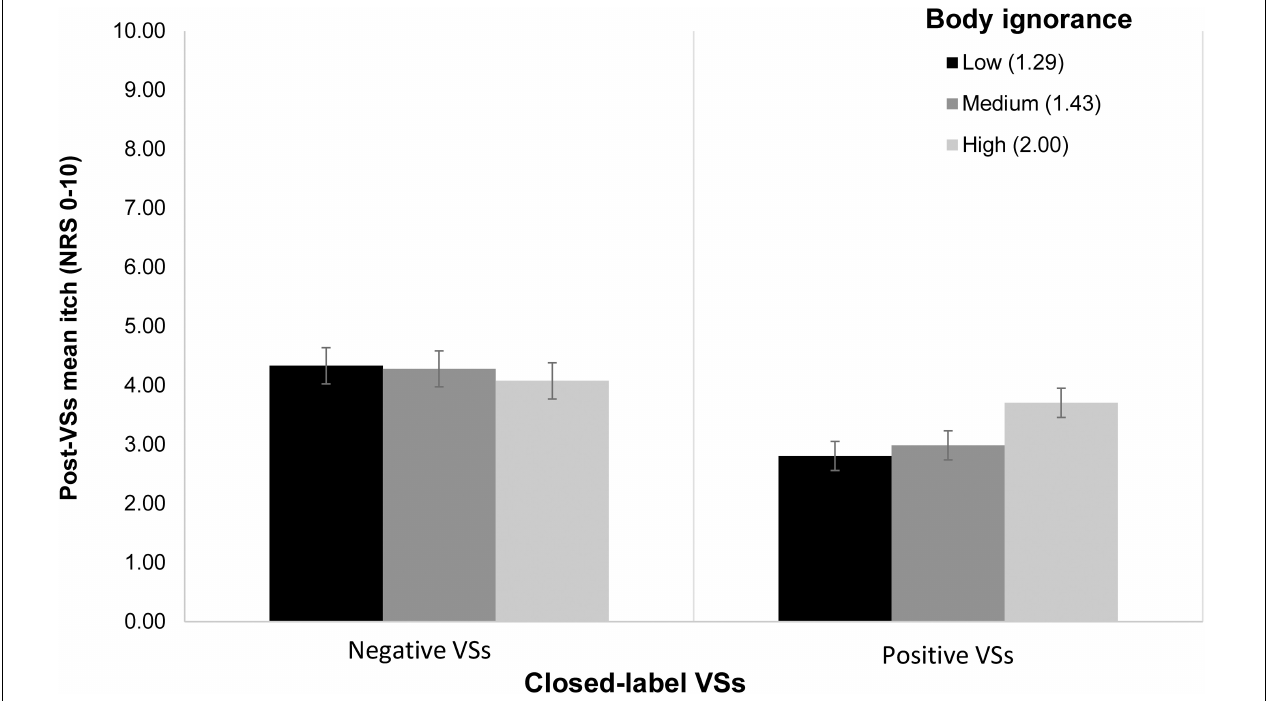
FIGURE 4 | Depiction of the marginal moderation of the direct effects of VSs on mean itch by ignorance of bodily signals in the closed-label (i.e., concealed) arms of studies 2 and 3: at low and medium levels of body ignorance, effects of VSs on itch were larger, with participants in the positive VSs group reporting lower levels of itch and participants in the negative VSs group reporting higher levels of itch. When participants tended to ignore bodily signals to a high degree, effects of VSs on mean itch were non-significant. The associations are depicted in the figure as mean itch ± SEM for low, medium and high levels of body